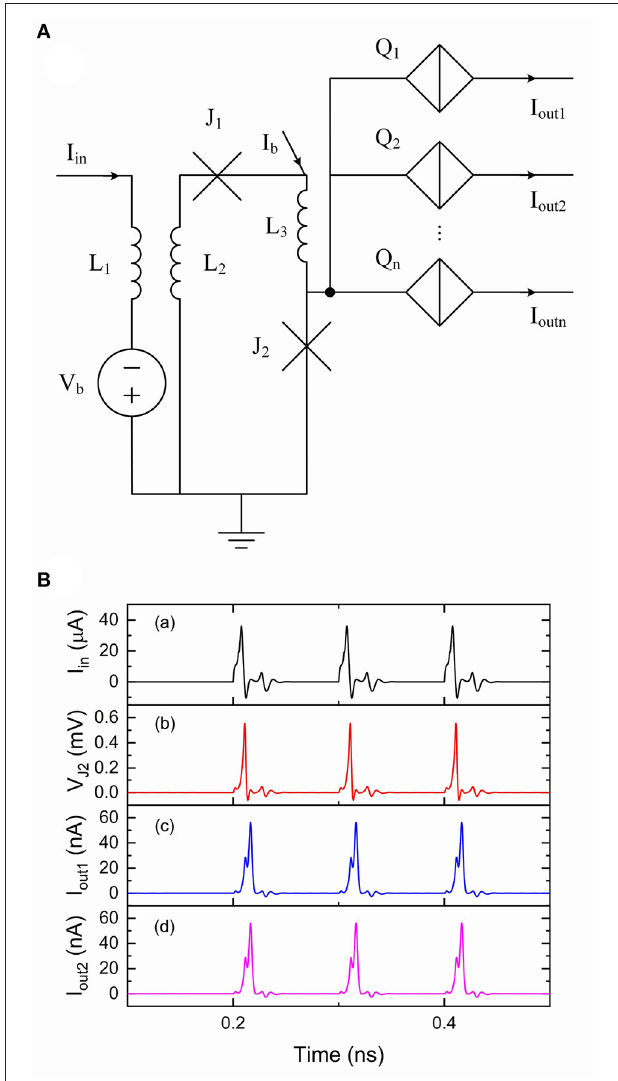
FIGURE 3 | A fan-out circuit is comprised of flux-charge and charge-flux circuits ( Cheng et al., 2021). The V c values used for Q 1 to Q 10 were 0.5 mV. The critical current I c value used for J 1 was 40 µ A and the I c value used for J 2 was 50 µ A . The inductance values used for L 1 and L 2 were 0.1 nH with a coupling coefficient of 0.9. The inductance value used for L 3 was 0.01 nH. Bias current I b was 70 µ A and bias voltage V b was 0.5 mV. Input current I in was from the output of a QPSJ-based IFN circuit that has a threshold of 500. (A) Circuit schematic. (B) Simulation results of the fan-out circuit. (a)